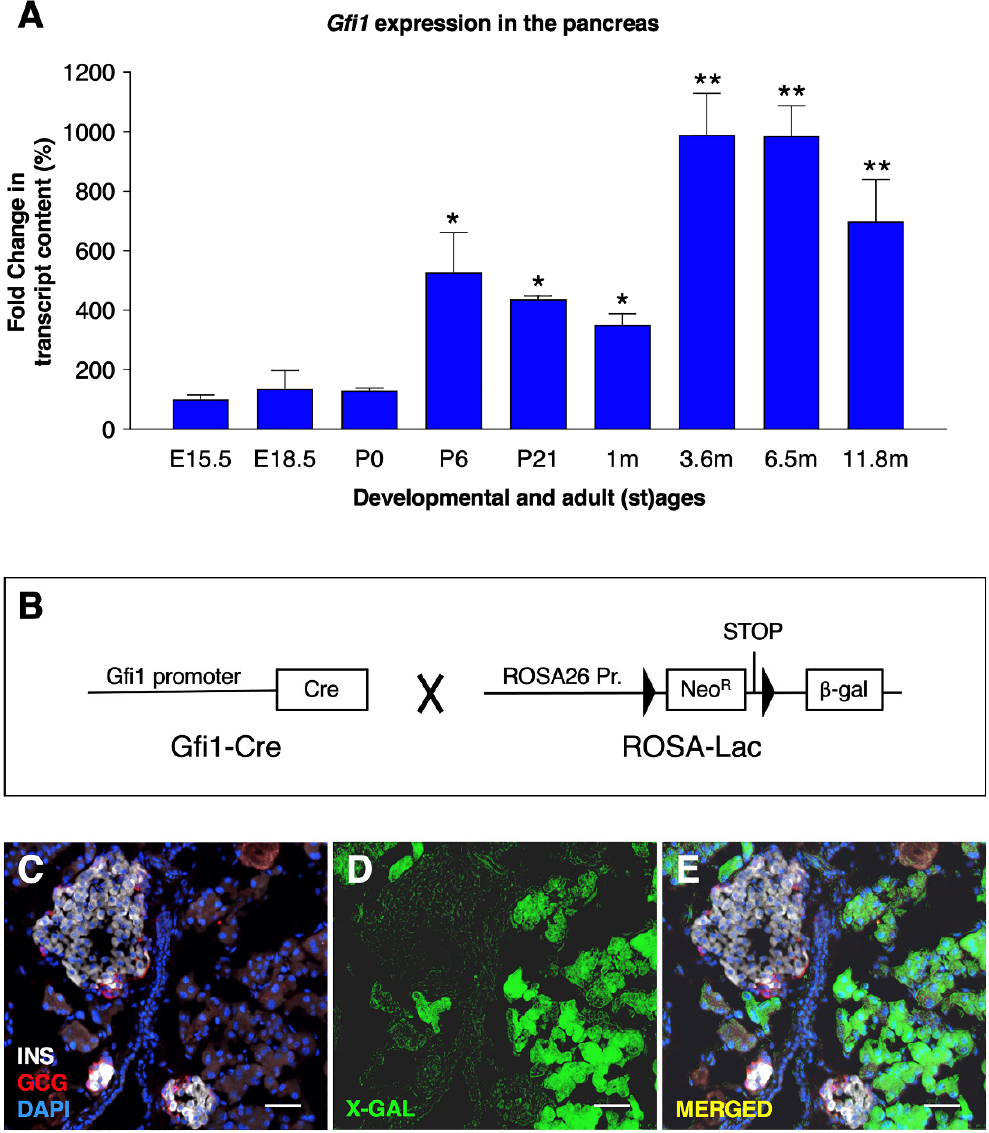
Figure 1. Gfi1 expression in the mouse pancreas. The expression levels of Gfi1 were assessed by RT-qPCR using RNAs from whole pancreata from control mice ( n = 6) at different developmental and adult (st) ages (* p < 0.05, ** p < 0.01). ( A ). Antibodies specifically recognizing Gfi1 are not commercially available. The Gfi1 expression pattern was therefore determined using a transgenic mouse line expressing a reporter gene under the control of Gfi1 promoter ( B ). Specifically, Gfi1-Cre animals (the Cre recombinase being knocked-in into the Gfi1 locus) were crossed with the Rosa26- β -gal mice (harboring a transgene composed of the ubiquitous Rosa26 promoter upstream of a LoxP-STOP-LoxP cassette followed by the β -galactosidase cDNA) . An X-gal staining was performed on 4-month-old Gfi1Cre::RosaLac animals (the blue channel was converted in green to increase the image readability) to reveal β -galactosidase activity. Objective magnification: 20×. Scale bar: 50 μ m ( C – E ). During postnatal stages (between P0 and P6) and early adulthood (between 1–3 m old), Gfi1 mRNA expression levels were found to significantly increase in a stepwise fashion. Thereafter, Gfi1 remained permanently and steadily expressed at all the stages analyzed, spanning from 3 months to 12 months of age (Figure 1A). The characterization of Gfi1 expression pattern in the murine pancreas was hindered by the lack of specific in situ probes or antibodies. Therefore, we generated a reporter mouse line, Gfi1Cre::RosaLac (Figure 1B). In the resulting animals, all cells having once- expressed Gfi1 were permanently labelled with the β -galactosidase reporter gene. Thus, the spatiotemporal expression of β -galactosidase driven by the Gfi1 promoter was assessed by